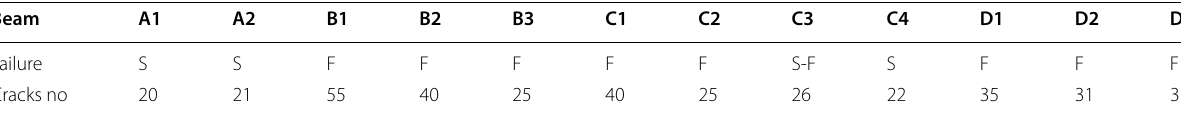
S is shear failure, F is tension flexure failure, S-F is shear flexure failure